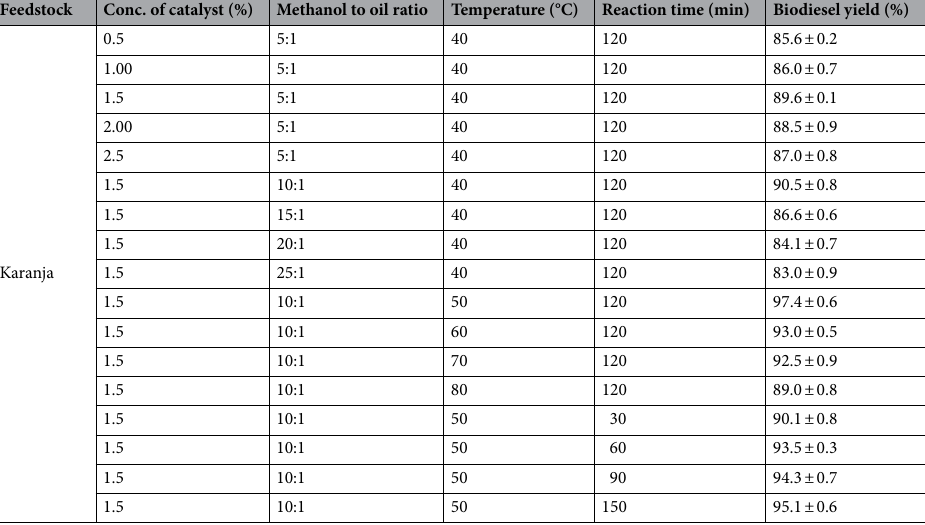
Table 3. Transesterification reaction parameters for karanja seed oil.